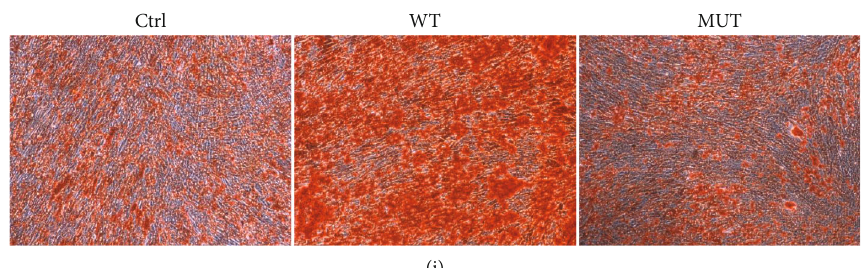
Figure 4: E ff ects of EDA on odontogenic di ff erentiation of hDPSCs. (a, b) mRNA expression level of EDA and DSPP in hDPSCs. There were signi fi cant di ff erences in the mRNA levels of wild-type and mutant EDA. (c) Western blot analysis of EDA and DSPP expression. (d) Human DPSCs transfected with mutant EDA expressed lower levels of p-p65 and p-IkB α than hDPSCs transfected with wild-type EDA. (e – h) Relative intensity of DSPP, EDA, p-p65, and p-IkB α . (i) Calcium nodule deposition of hDPSCs after transfection was examined by Alizarin Red S staining. Mutant EDA showed a decreased capacity of odontogenic di ff erentiation compared with those transfected with wild-type EDA. Data are expressed as the mean ± SD . Each experiment was repeated three times with n ≥ 3 samples per group. ∗ P < 0 : 05 and ∗∗ P < 0 : 01 .